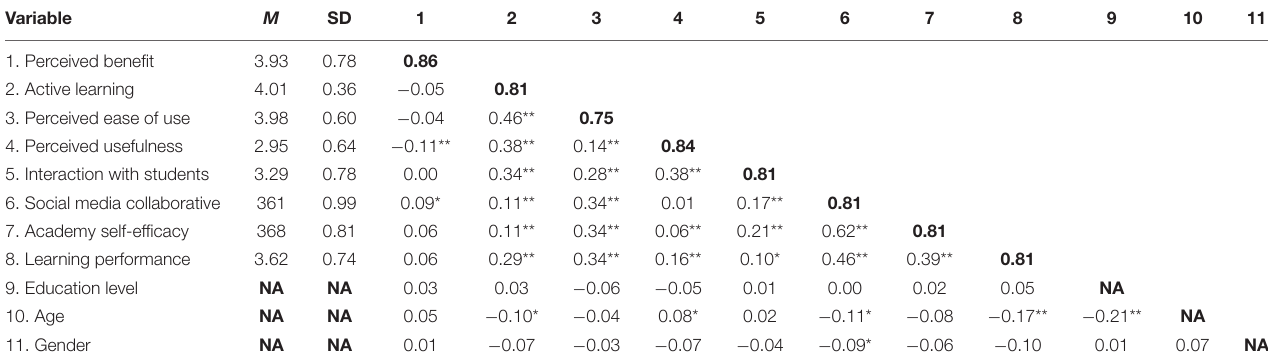
TABLE 2 | Means, standard deviation, and correlations. Variable